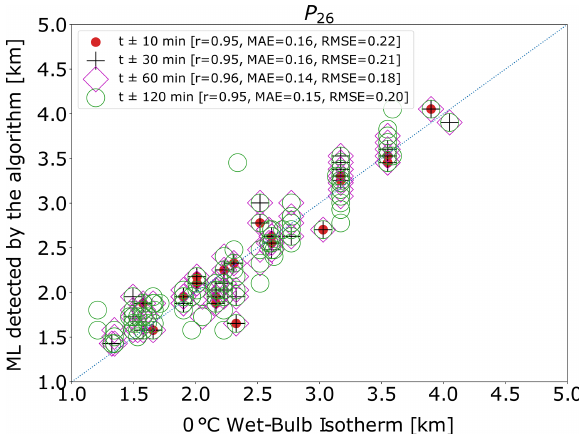
Figure 9. Heights of the 0 ◦ C wet-bulb isotherm versus ML detected by the algorithm using the combination P 26 for several time win- dows. The 1:1 line is shown in blue. MAE and RMSE are shown in kilometres.